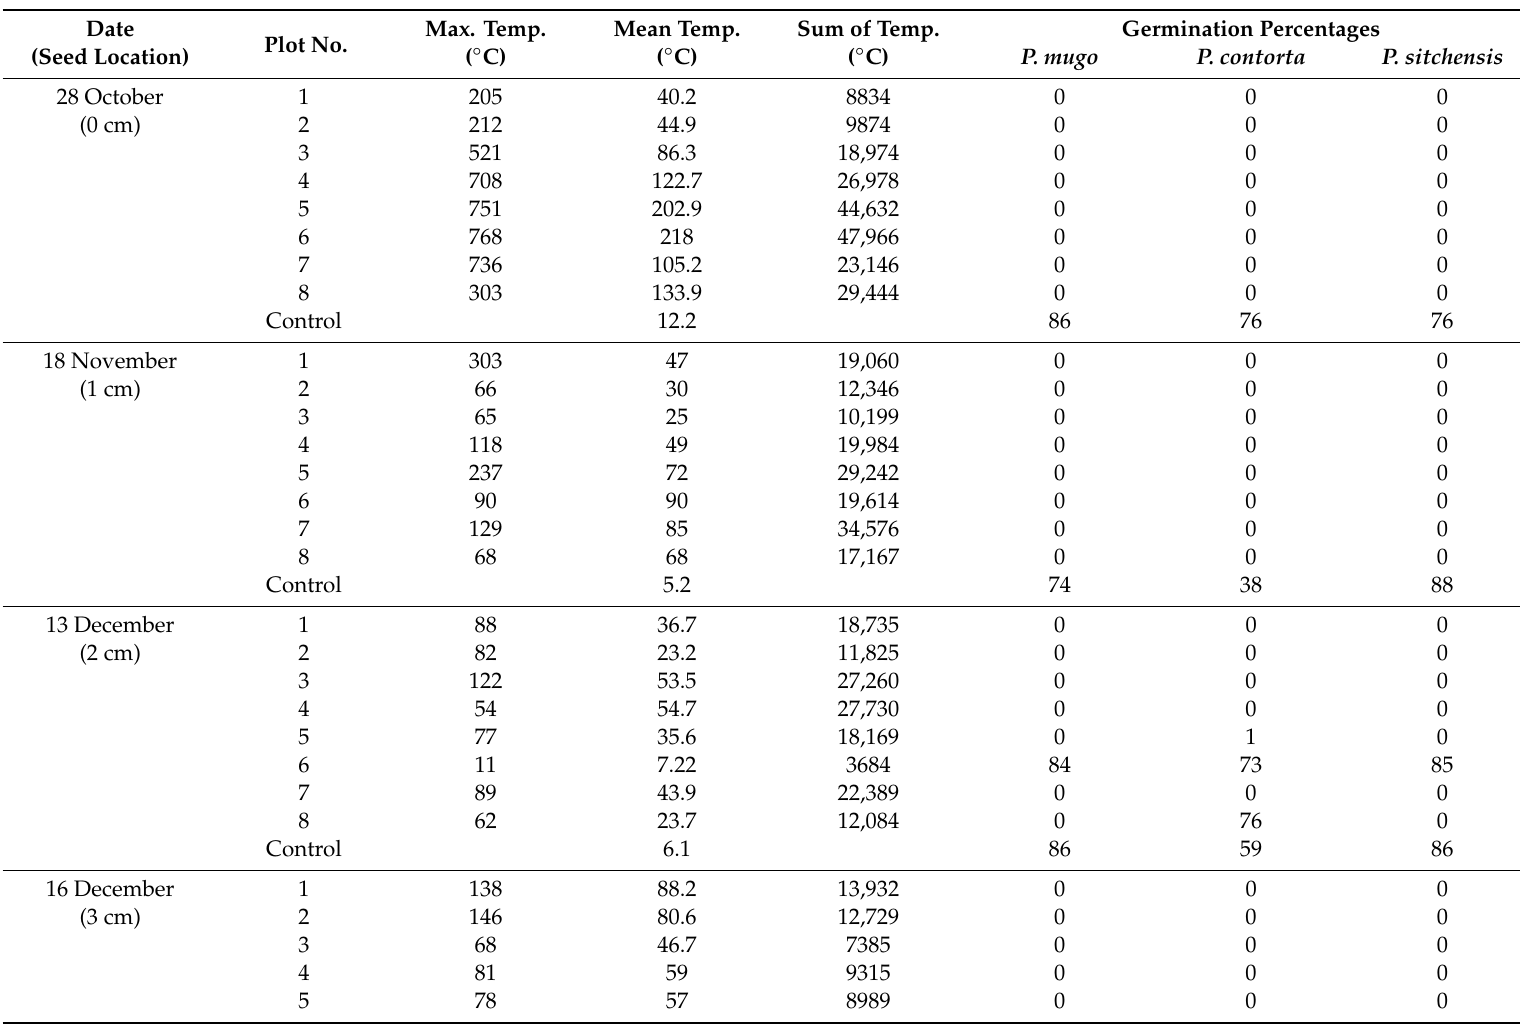
Table 2. Maximum, mean and sum of temperatures at each of the eight seed locations in the eight fires and the germinations percentages tested afterward. Plot